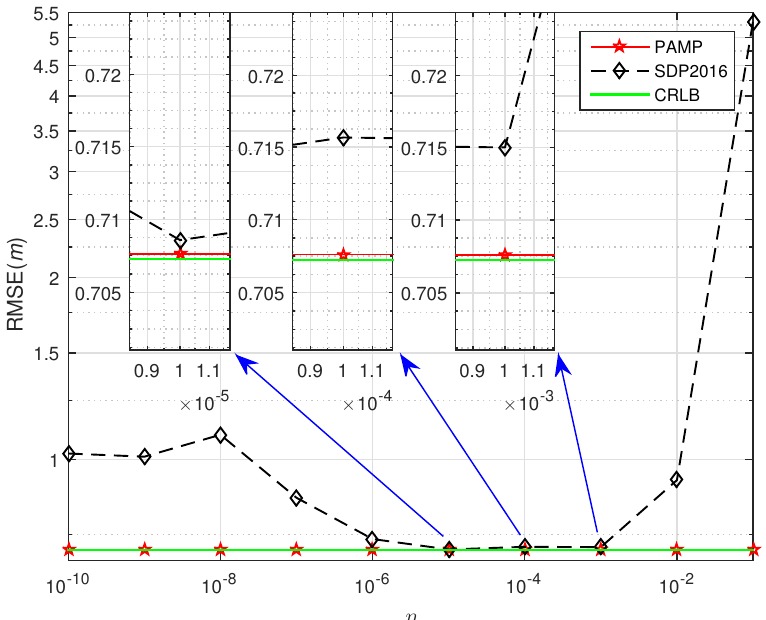
Figure 3. Selection of the penalty factor η in SDP2016 when σ 2 = 0 dB for near-field case in scenario 1.